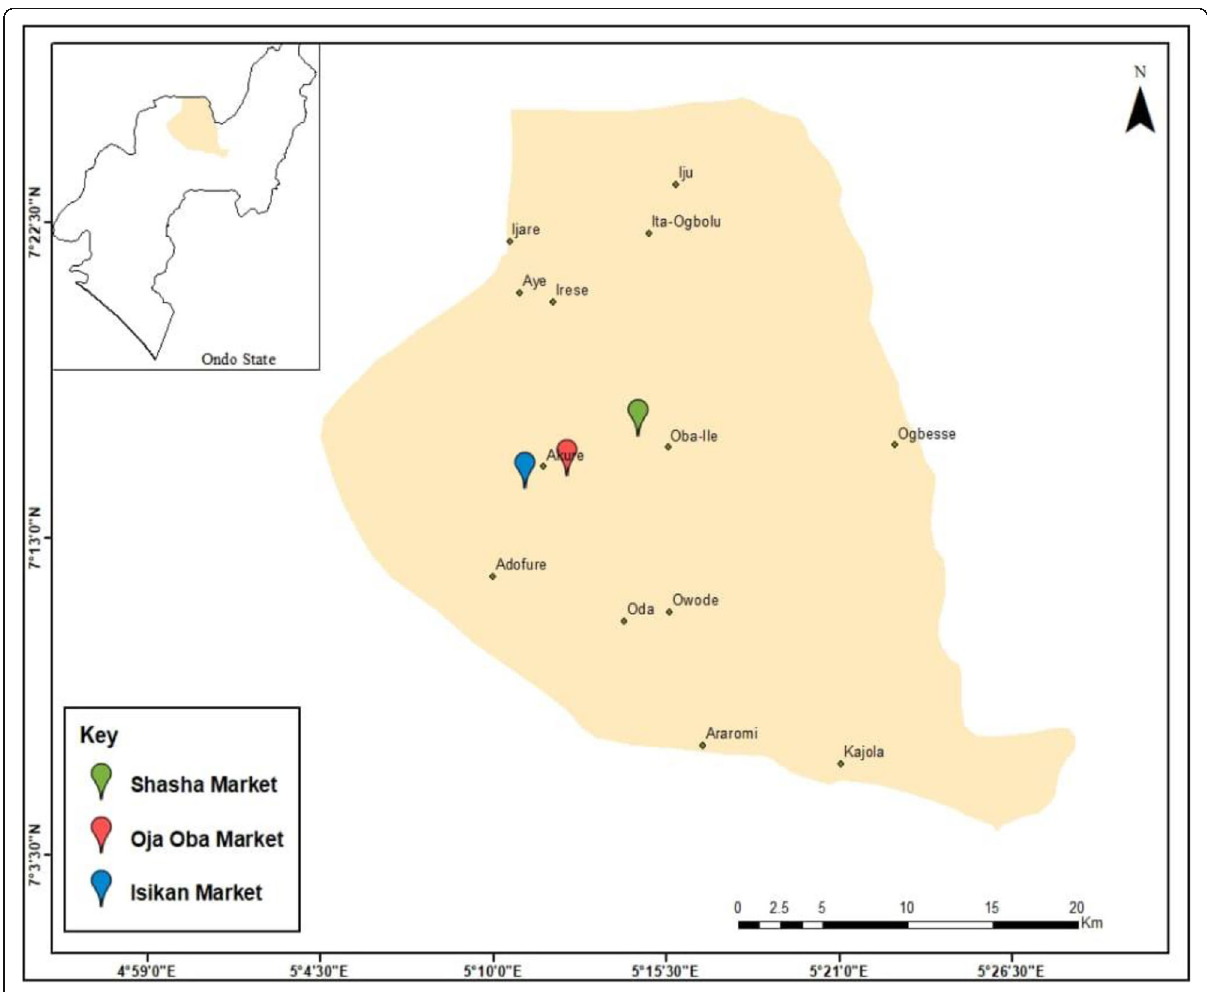
Fig. 1 Location of the selected markets in